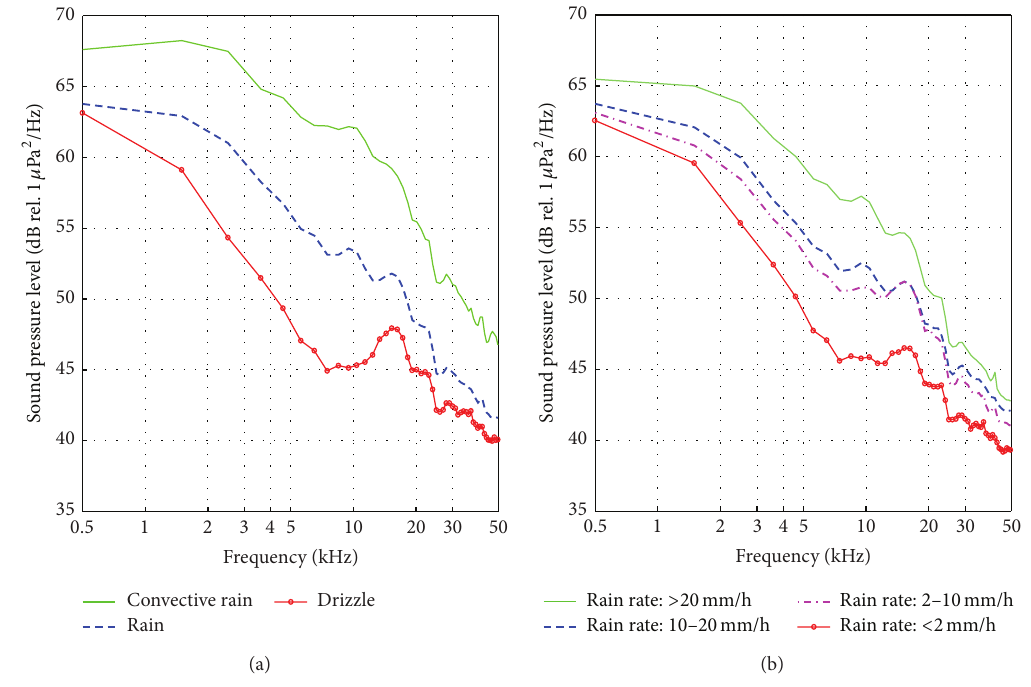
Figure 6: (a) Average sound spectra for different types of precipitation: convective rain, rain, and drizzle as classified by PAL; (b) average sound spectra subdivided into rainfall rate categories: 0–2, 2–10, and 10–20, over 20 mm/h, respectively, as measured by the rain gauge on board the